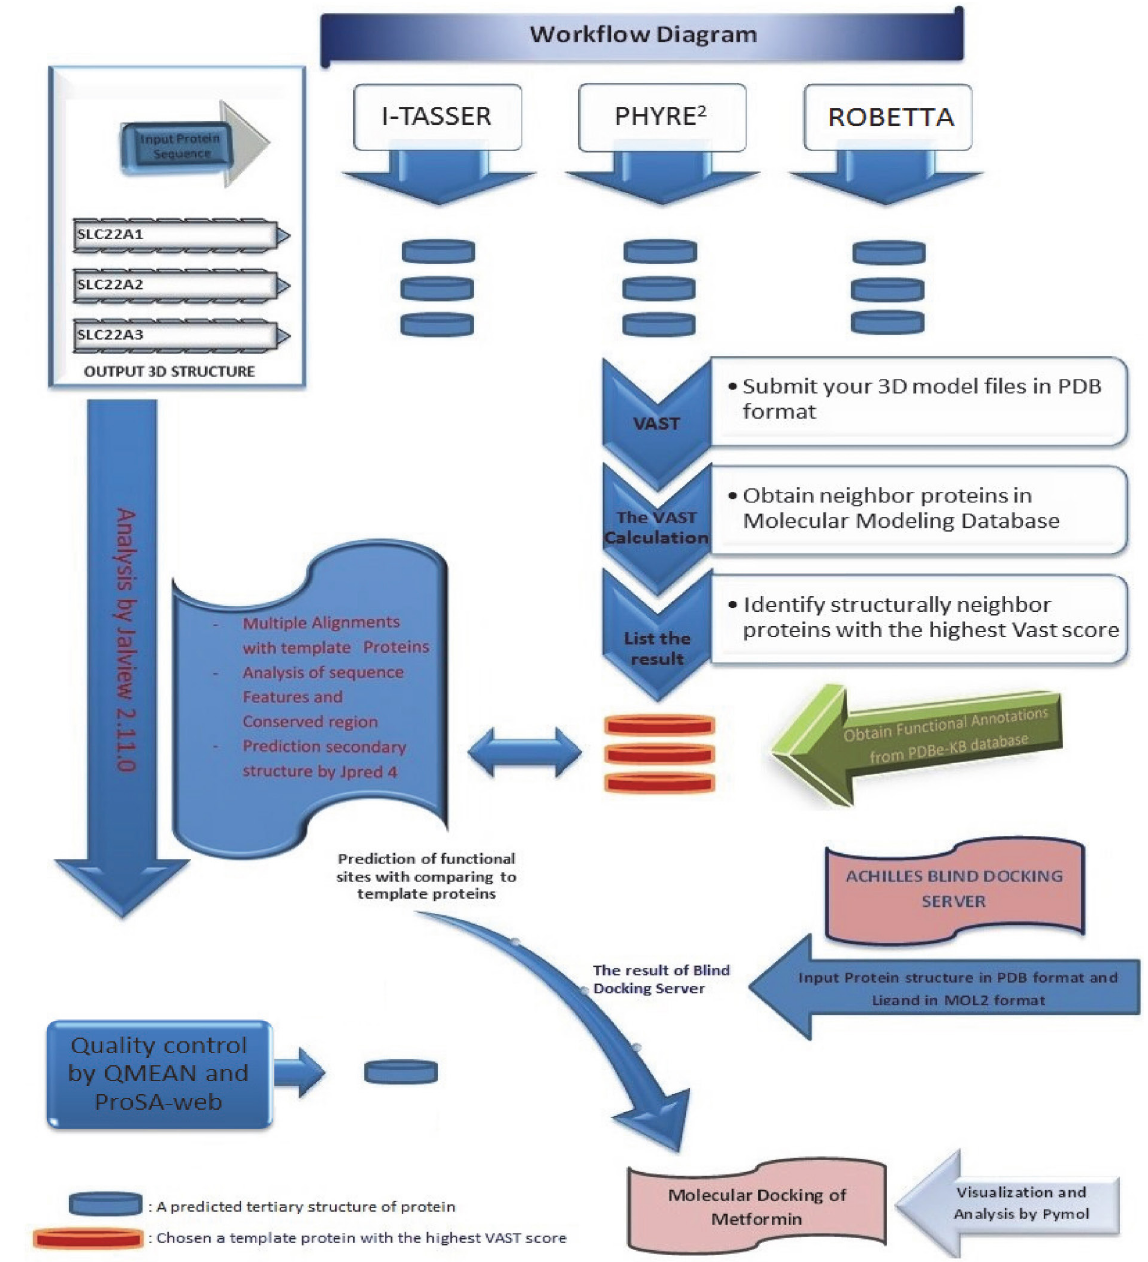
Figure 1. The identification of the molecular modeling of OCT1-3 and metformin. There are four main steps in the workflow. The first step is the prediction of the 3D structure of OCT1-3 proteins and quality control of the model protein structures. The second one is the identification of the template proteins with the VAST. The third one is the analysis of the sequence data by Jalview 2.11.0 while the fourth is the molecular docking by Achilles Blind Docking